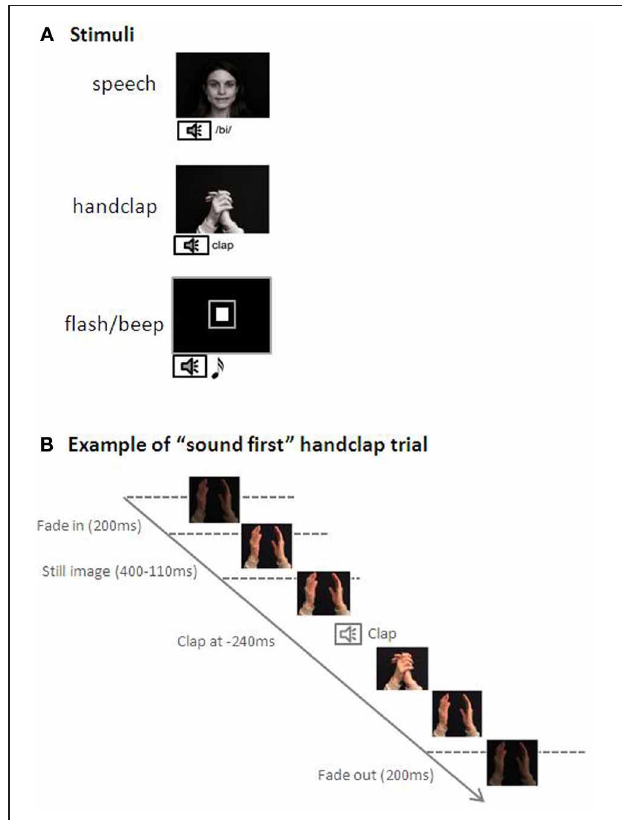
FIGURE 1 | (A) Examples of the stimuli used in the three conditions; speech, handclap, and flash/beep. (B) Depiction a “sound first” [the sound (handclap) is presented at − 240ms] trial in the handclap condition.